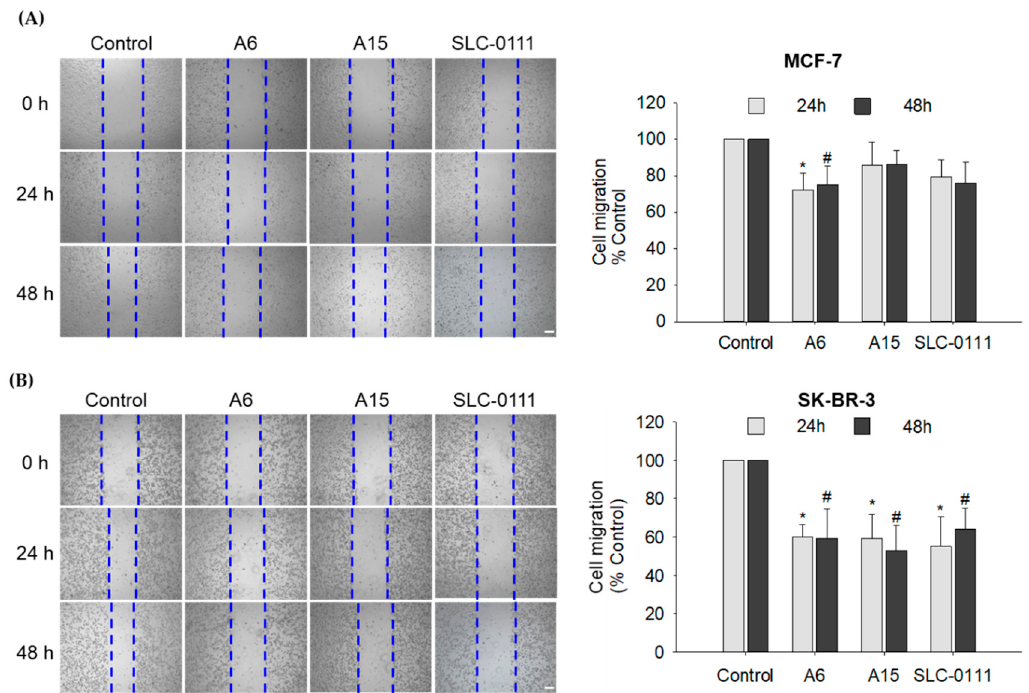
Figure 7. Effects of A6 and A15 on the migration of MCF-7 and SK-BR-3 cells. ( A ) MCF-7 and ( B ) SK-BR-3 cells were treated with A6 , A15 , or SLC-0111 at 50 μ M for 24 or 48 h. Control cells were treated with serum-free media containing 0.1% DMSO instead. Cell migration was determined by wound healing assay, as described in the Materials and Methods. Representative images are shown. Data are displayed as mean ± SEM from three independent experiments. * p < 0.05 and # p < 0.05 vs. the vehicle-treated control cells for 24 and 48 h, respectively. Scale bar, 250 μ m.